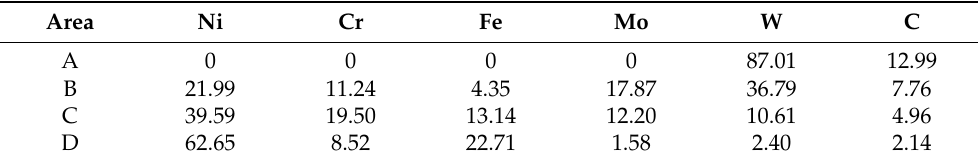
Figure 5. SEM image of the undissolved WC particles in the 5 WC coating. A—WC particles, B—The melting area of WC particles, C—Dendritic structure, D—Substrate structure. Table 4. EDS analysis of undissolved WC particles (wt.%).